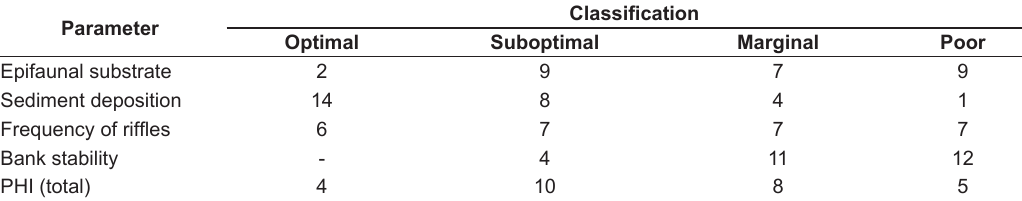
Table 4. Number of streams by PHI parameter